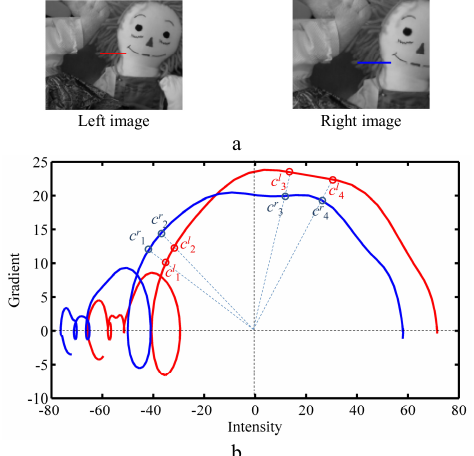
b Figure1. (a) One part of left and right corresponding scanlines; (b) Intrinsic curves of the left and right scanlines ( C l , C r ) in red and blue,